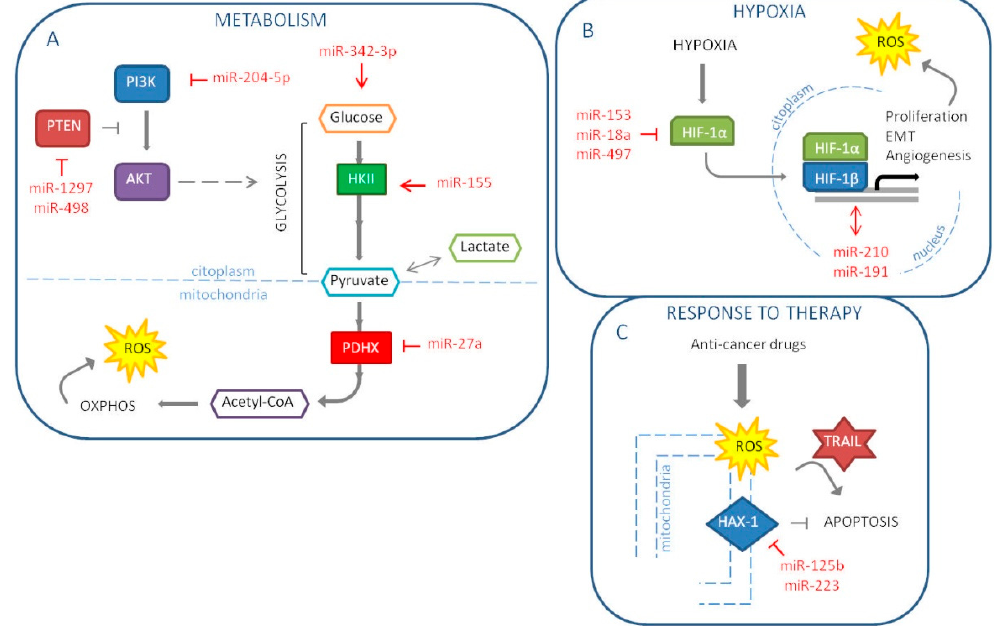
Figure 3. MiRNAs involved in the regulation of hallmarks of cancer influenced by oxidative stress in breast cancer: metabolism ( A ), hypoxia ( B ) and response to therapy ( C ) (The red arrow indicates upmodulation, the red “T” stands for